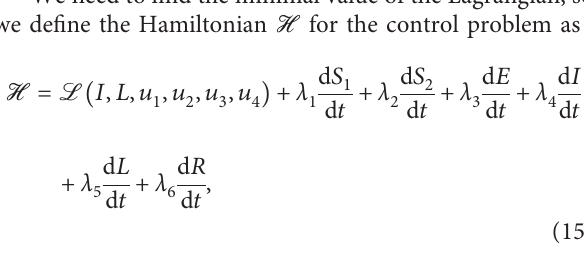
. All parameter 0